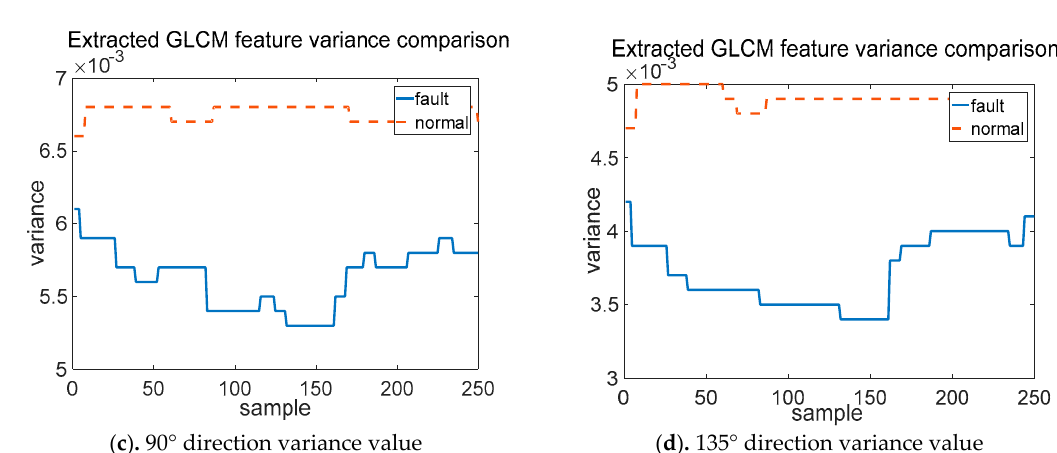
Figure 8. GLCM feature variance value comparison chart.